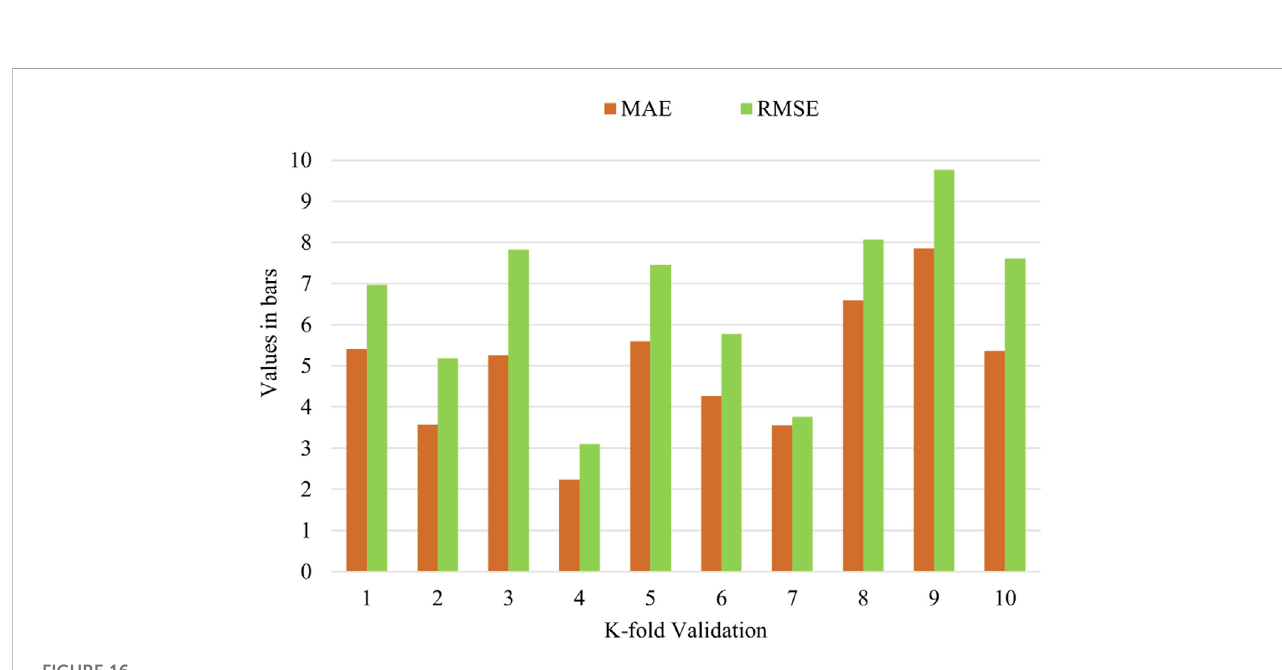
FIGURE 16 SVM model statistical